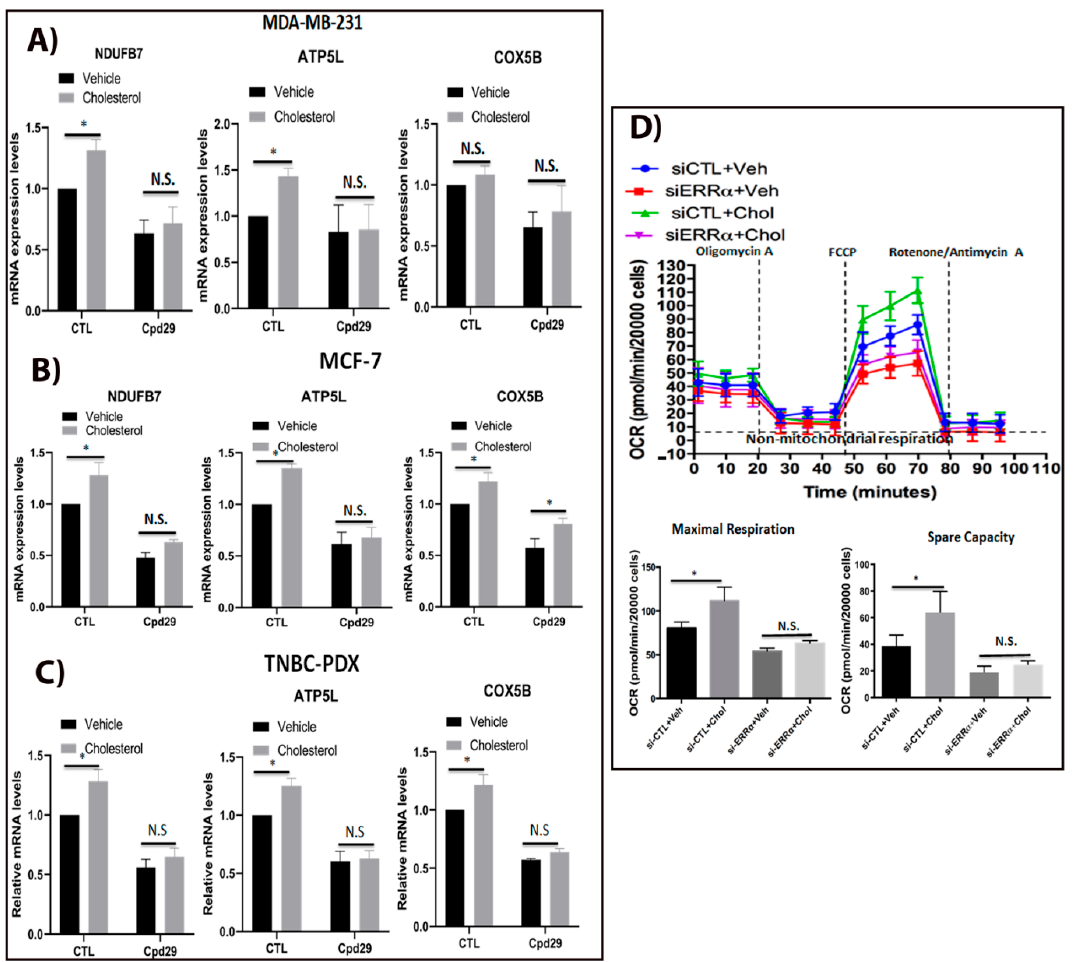
Figure 2. Cholesterol induces cellular respiration in ER+ and TNBC cells via ERR α . ( A – C ) MDA-MB-231 cells were treated with vehicle (Veh), cholesterol (Chol, 5 μ M), and/or cpd29 (5 μ M) for 48 h. Additionally, MCF-7 and TNBC-PDX cells were treated with vehicle (Veh), cholesterol (Chol, 10 μ M), and/or cpd29 (10 μ M) for 48 h. Total RNA was extracted and ana- lyzed by RT-qPCR. Genes detected include: NDUFB7: NADH dehydrogenase (ubiquinone) 1 beta subcomplex subunit 7, ATP5L: ATP synthase subunit g (mitochondrial), and COX5B: Cytochrome c oxidase subunit 5B (mitochondrial). The